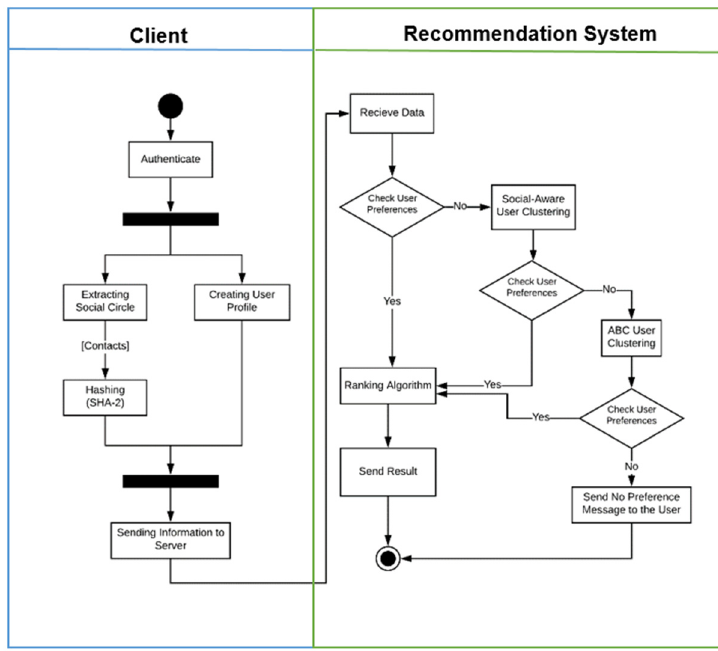
Figure 5. The swim-lane diagram showing the process flow of the proposed system.